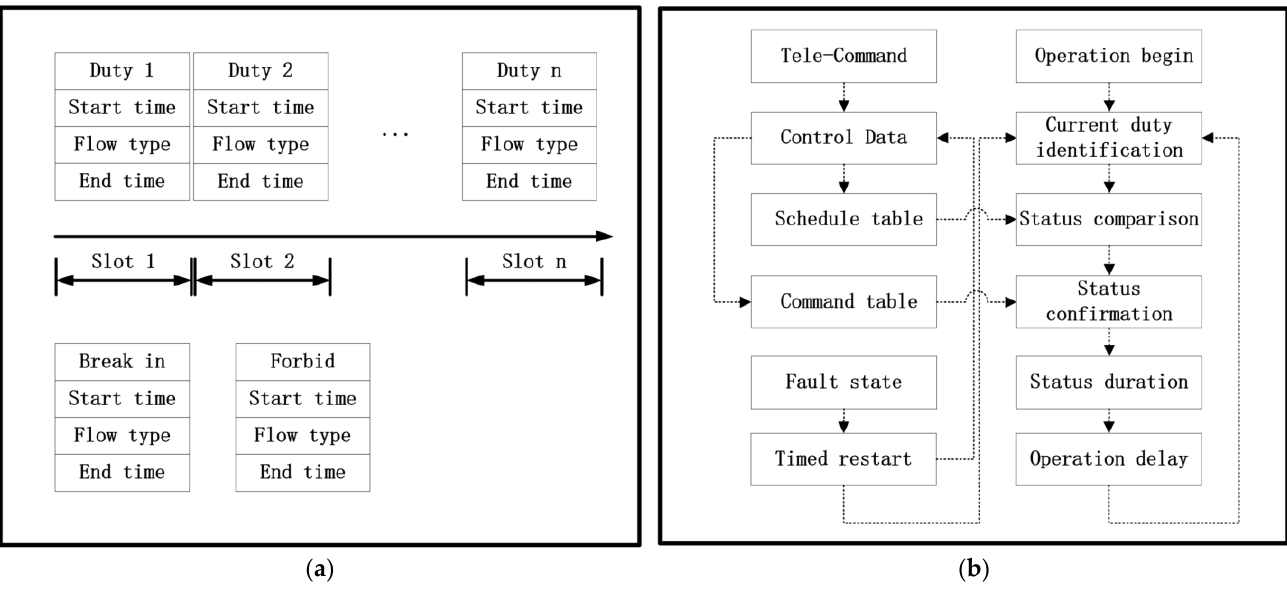
Figure 10. Operation functions: ( a ) Multiple duty operation control; ( b ) Schedule strategy.